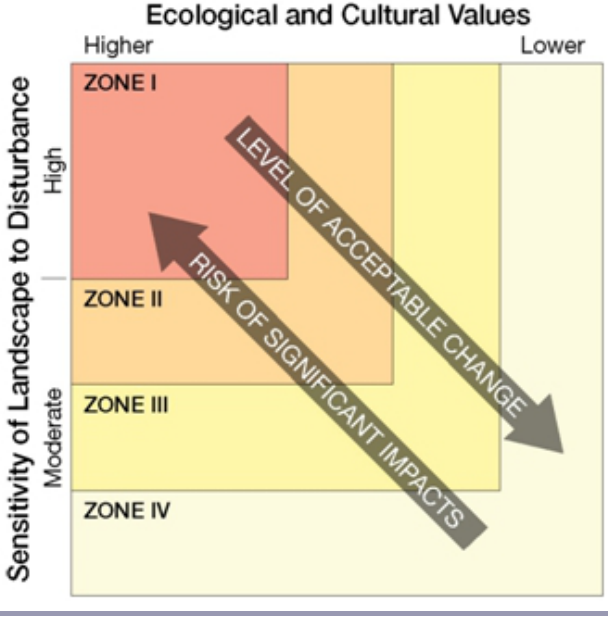
Fig. 2 . Zoning considerations for the North Yukon Regional Land Use Plan integrated management